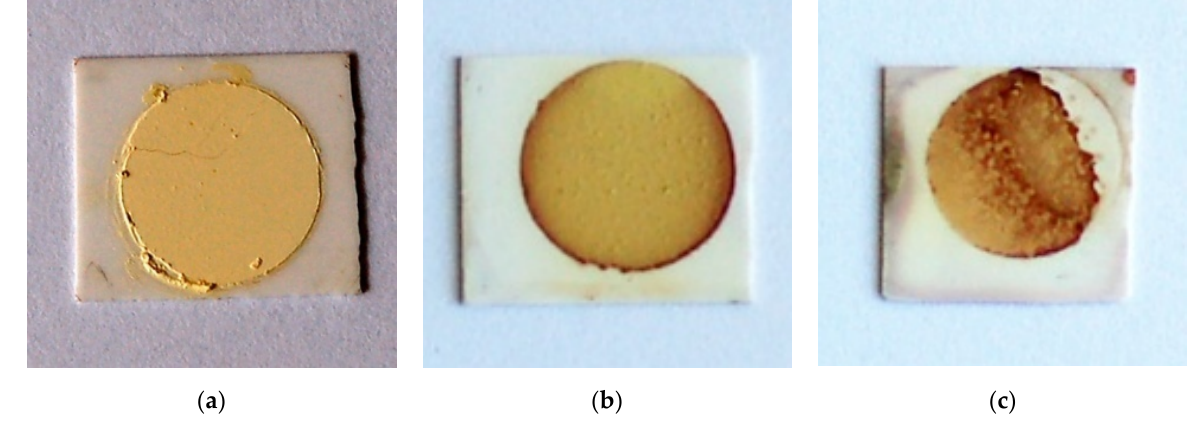
Figure 2. Optical images of TiTe 3 O 8 films deposited on carbon coated 25.4 × 25.4 × 0.0254 mm 3 alumina substrates and sintered at 680 ( a ), 700 ( b ) and 720 ◦ C ( c ) for 5 h, respectively. Films sintered at 680 ◦ C are not fully dense and some films sintered at 720 ◦ C exhibit an irregular surface with a reddish colour resulting from a reaction with the alumina substrate.